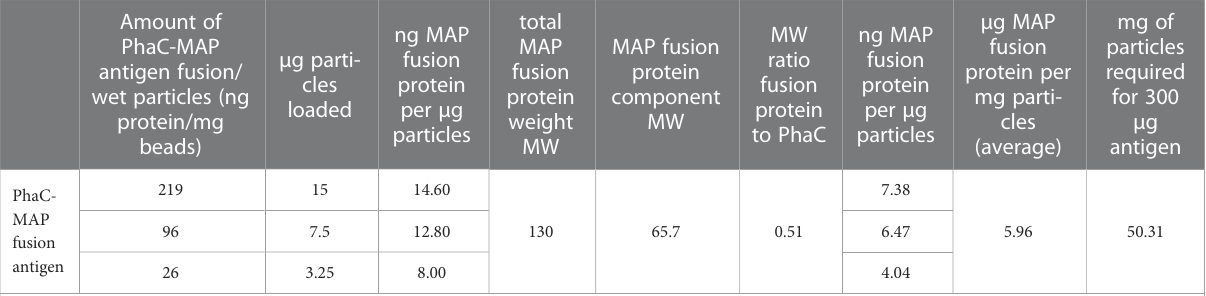
TABLE 1 Concentration of MAP fusion antigen in protein particles.